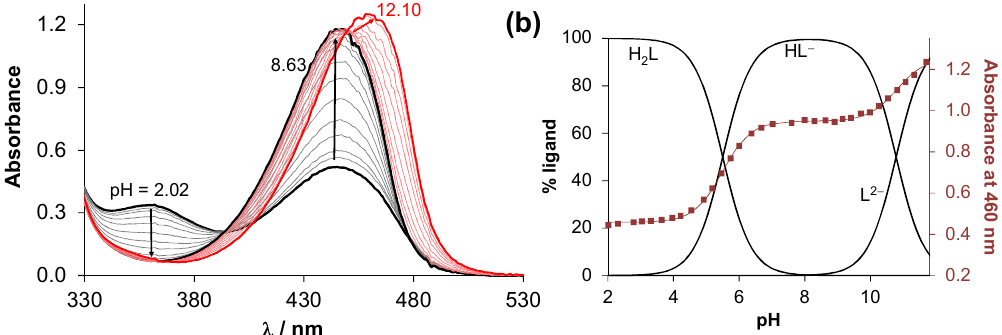
Table 1. p K a values of HQNO 2 -L-Pro determined by various methods. { t = 25.0 °C}.